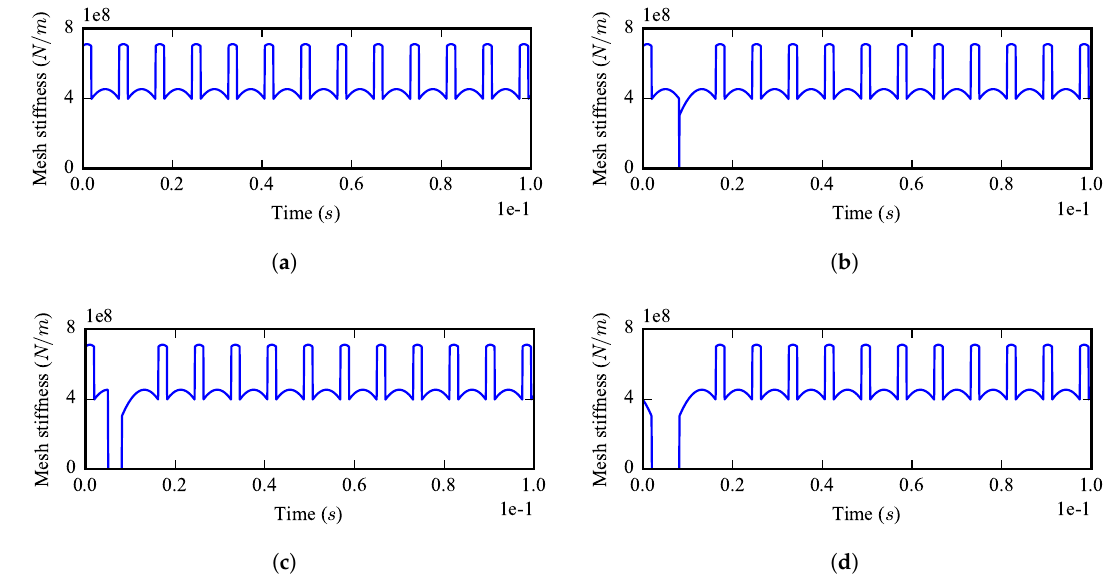
Figure 4. The mesh stiffness of the sun-fault planet gear pair with different breakage sizes: ( a ) p = 0, ( b ) p = 0.2, ( c ) p = 0.5 and ( d ) p =